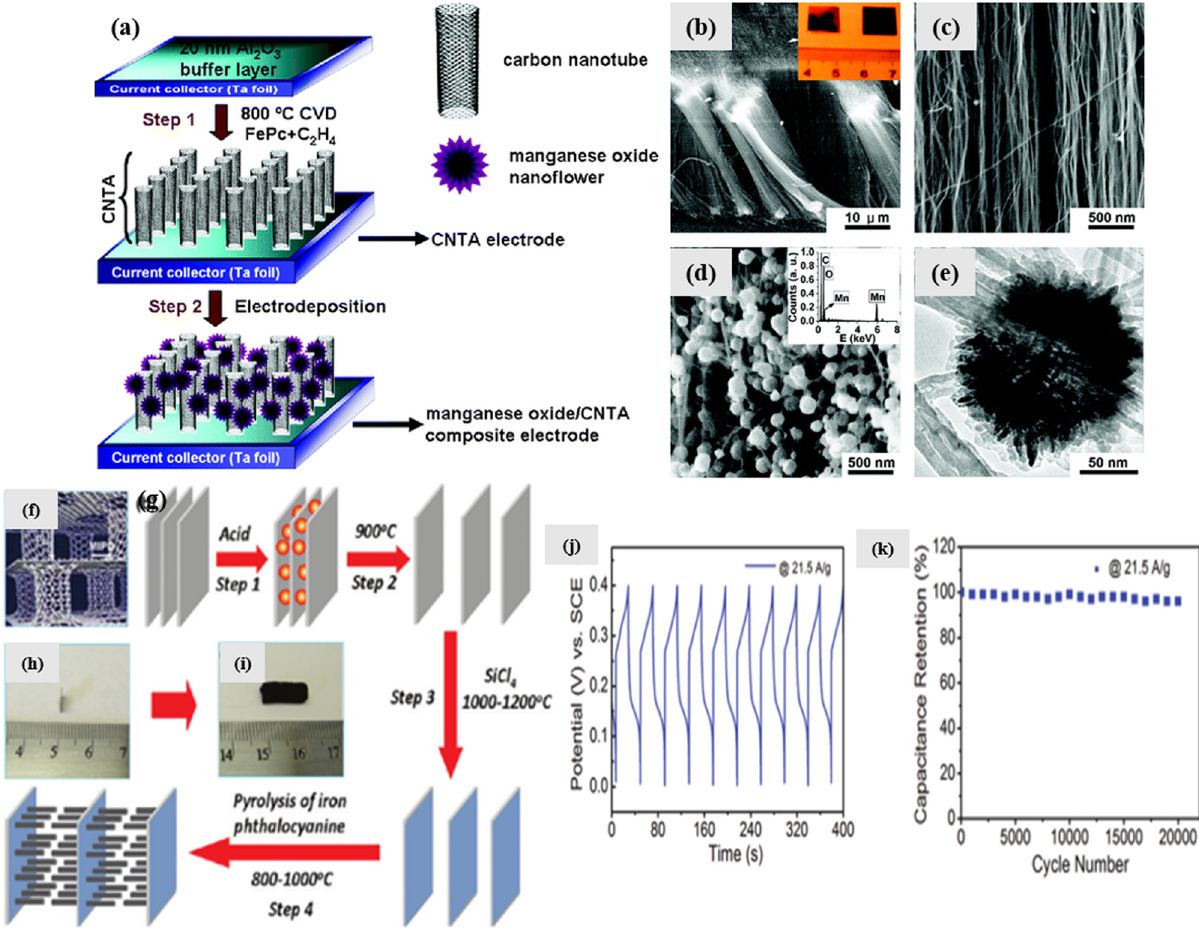
Figure 5: A typical example of VACNT electrode materials for an SC. ( a ) Preparation process of manganese oxide/VACNT composite materials. The morphology and microstructure of VACNT and the manganese oxide/VACNT composite materials. ( b and c ) SEM images with di ff erent magni fi cations of the VACNT and a photo ( inset of a ) of the original ( left ) and VACNT - covered ( right ) Ta foil. ( d ) SEM image of manganese oxide/VACNT composite materials and its EDX pattern ( inset ) . ( e ) TEM image of a manganese oxide nano fl ower [ 20 ] . Copyright 2008, American Chemical Society. ( f ) Schematic of a three - dimensional ( 3D )- pillared VACNT - graphene nanostructure. ( g ) Schematic of the procedure for the preparation of the 3D - pillared VACNT - graphene architectures. Photograph of ( h ) original highly oriented pyrolytic graphite ( HOPG ) with a thickness of 80 μ m and ( i ) the thermally expanded graphene layers intercalated with VACNTs. ( j ) The galvanostatic charge